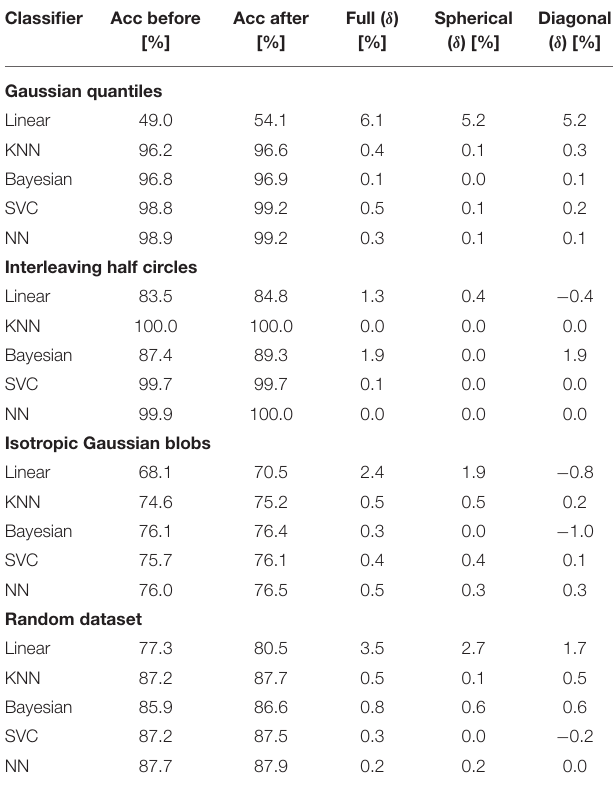
Algorithm 1 : 2D Accuracy Gridexploration TABLE 2 | Accuracy of five classifiers before and after applying Box-Cox transformation using three optimization strategies.